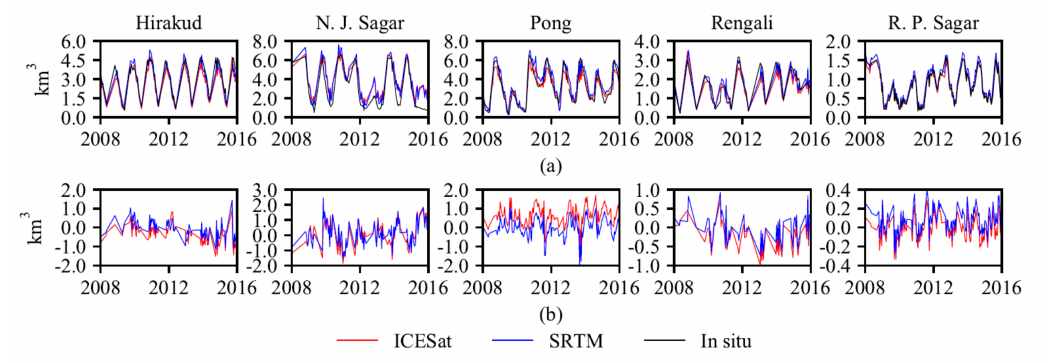
Figure 5. Validation results by comparing the remotely sensed storage values with gauge observations: ( a ) Comparison among absolute storage values; ( b ) comparison of storage di ff erence (remotely sensed storage minus gauge data).